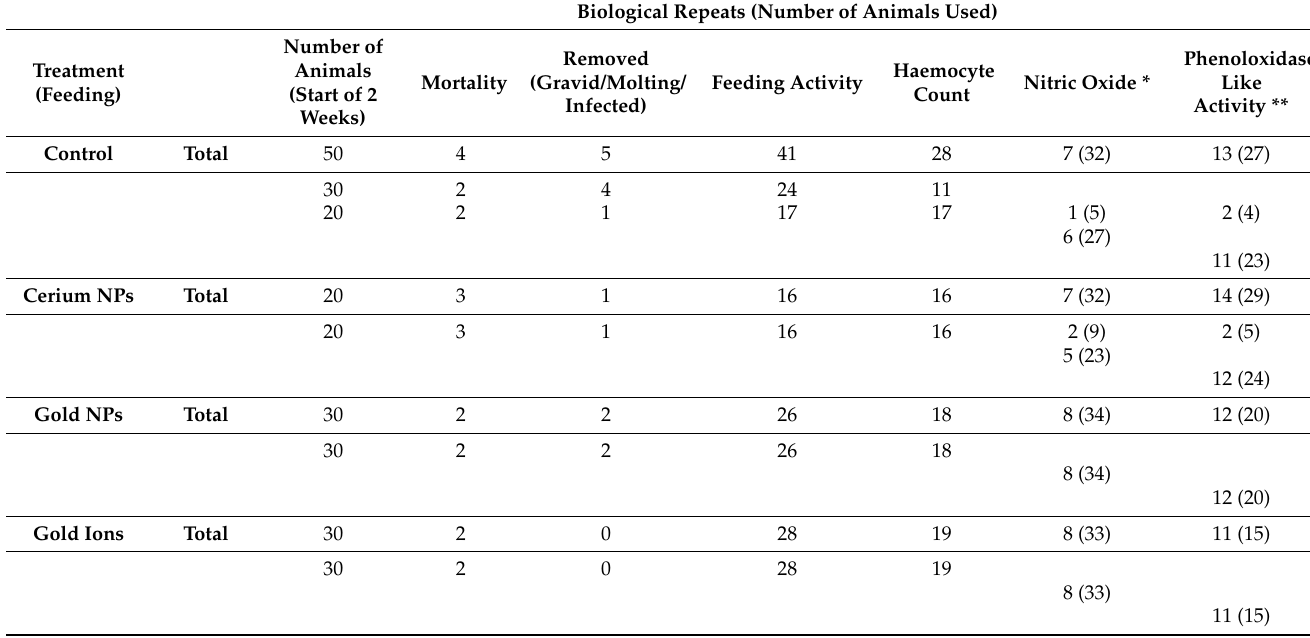
Figure A1: Physiochemical characterisation of PVP-coated Au NPs and scanning electron microscopy (SEM) of dried leaves covered with PVP–Au NPs. Table A1: Details the number of animals used in the feeding experiment. Table A2: Details the number of animals used in the injection experiment. Table A1. Details the number of animals used in the feeding experiment, the mortality rate, and the stages of the investigation. *, pooled from 4–5 animals; **, pooled from 1–3 animals. Biological Repeats (Number of Animals